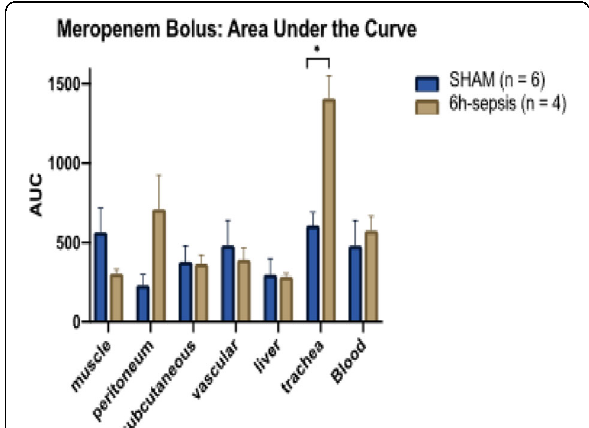
Fig. 3 (abstract 001019). Comparison of tissue concentration AUC between 6h-septic and sham-operated rats